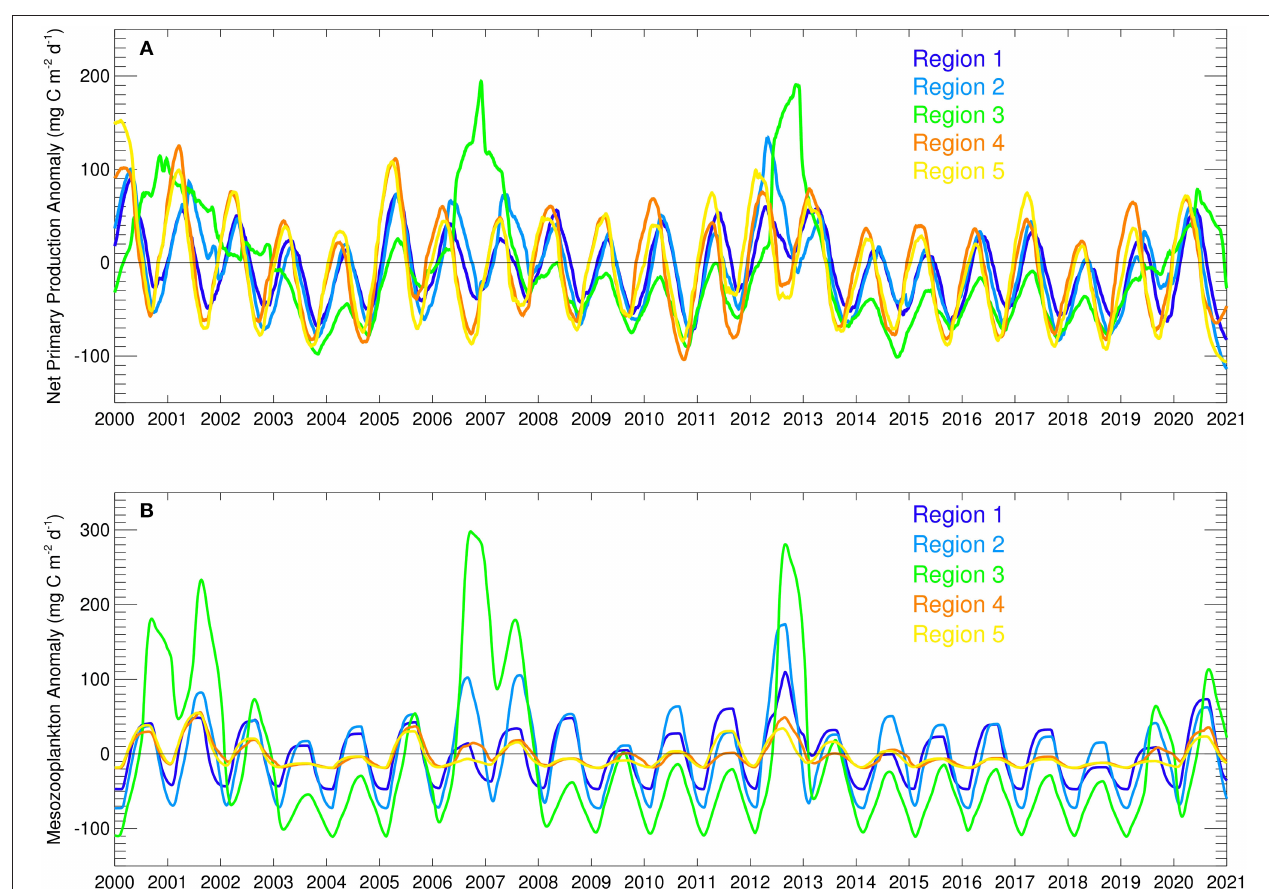
FIGURE 9 | Time series of modeled (A) net primary production anomalies (mg C m − 2 d − 1 ) and (B) mesozooplankton biomass anomalies (mg C m − 2 d − 1 ) in the five different